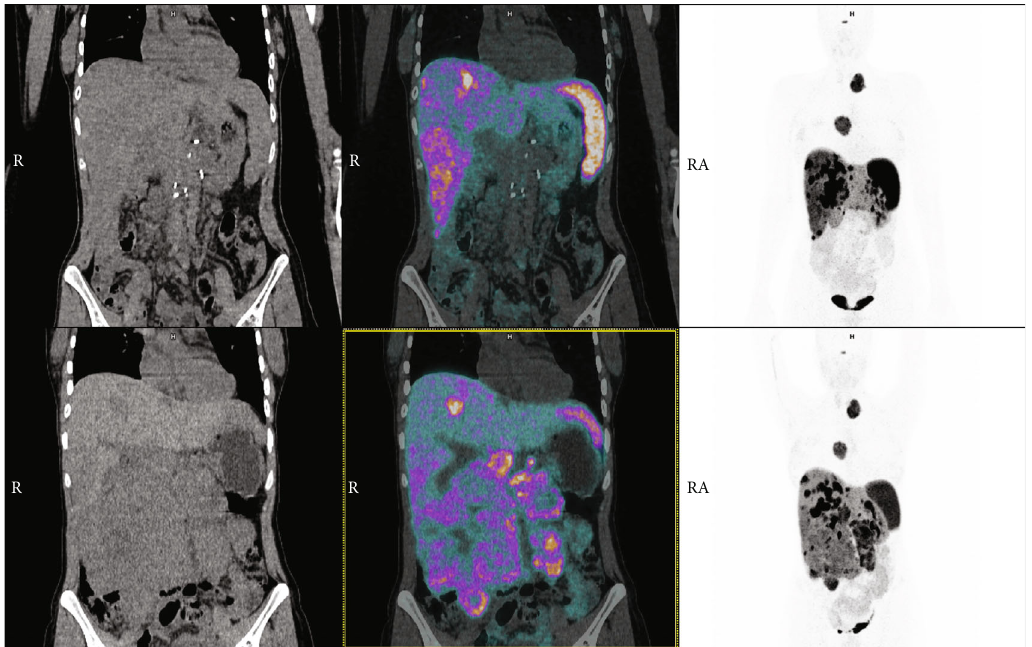
Figure 3: 68 Ga-DOTATATE